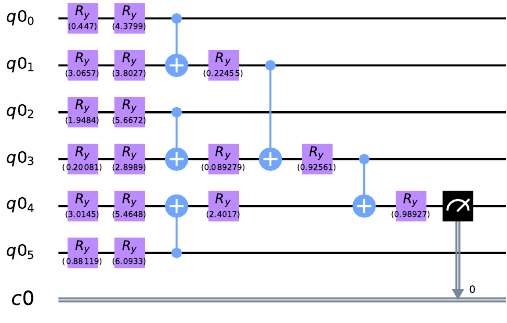
Figure 5. 6 Qubit Tree Tensor Network (TTN) representation of the Quantum Edge